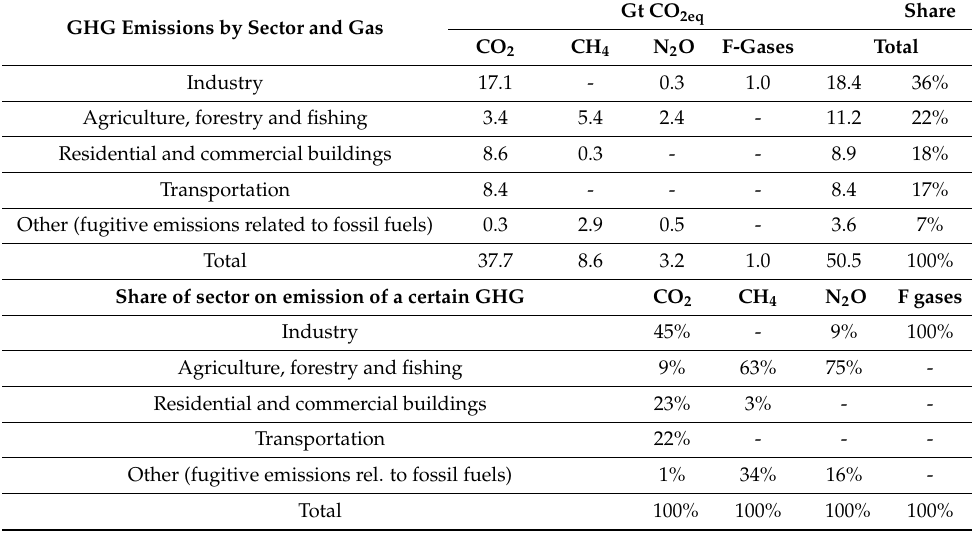
Table 6. Global GHG emissions by sector and by greenhouse gas 2016 (data from